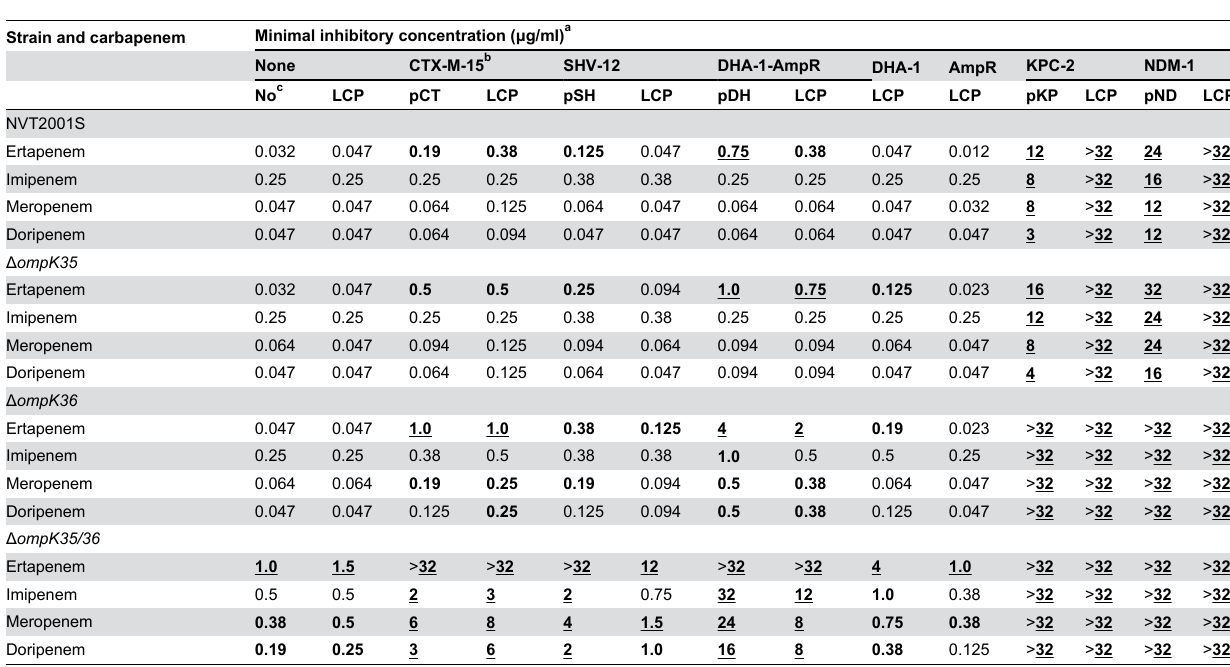
Table 6. MICs of carbapenems against K. pneumoniae NVT2001S and its derived strains.